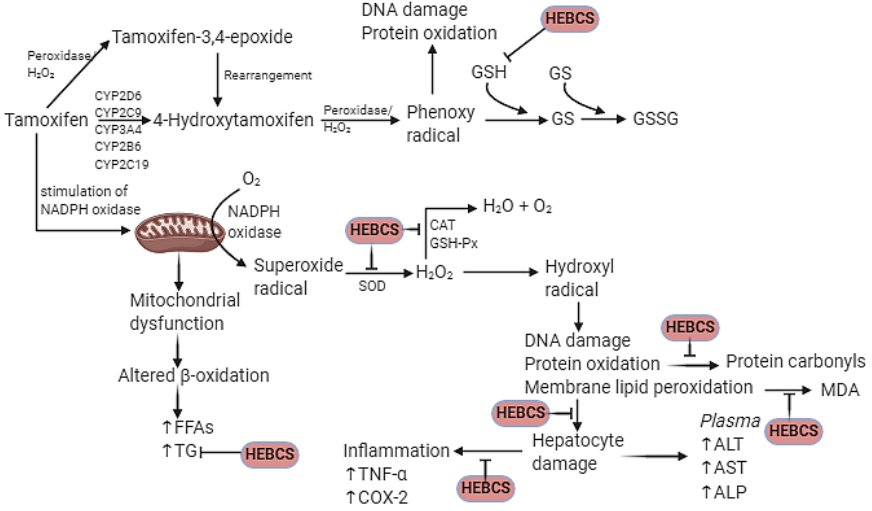
Figure 14. Proposed mechanism by which HEBCS alleviate Tamoxifen induced hepatotoxicity in rat (created at www.BioRender.com, accessed on 4 August 2021). CYP, cytochrome P450; TNF-α, tumour necrosis factor alpha; FFA, free fatty acid; HEBCS, hydroethanolic extract of Buchholzia coriacea seeds; ALT, alanine aminotransferase; AST, aspartate aminotransferase; ALP, alkaline phosphatase.